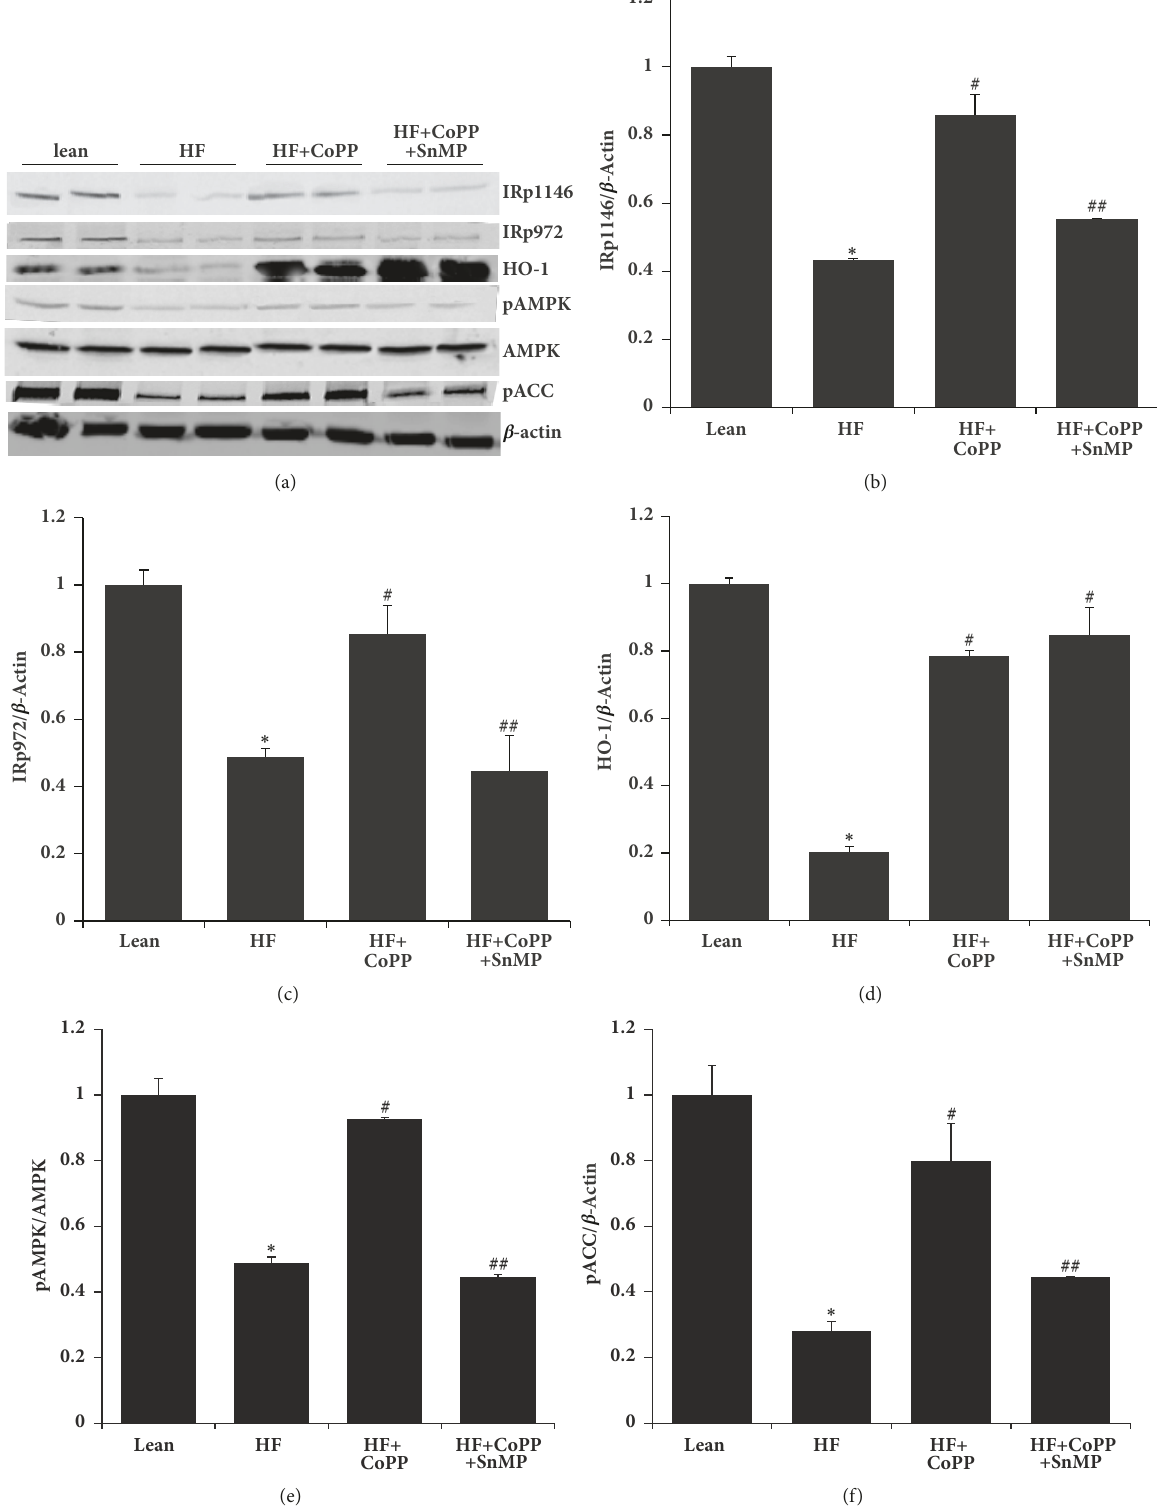
Figure 6: Adipose tissue HO-1 upregulation increases phosphorylation of both insulin receptor and ACC. Representative western blot (a) and densitometry analysis of (b) IRp1146, (c) IRp972, (d) HO-1, (e) pAMPK, and (f) pACC. Results are mean ± SE, n=4, ∗ p < 0.05 versus lean mice, #p < 0.05 versus HF fed mice, and ##p < 0.05 versus HF fed mice +